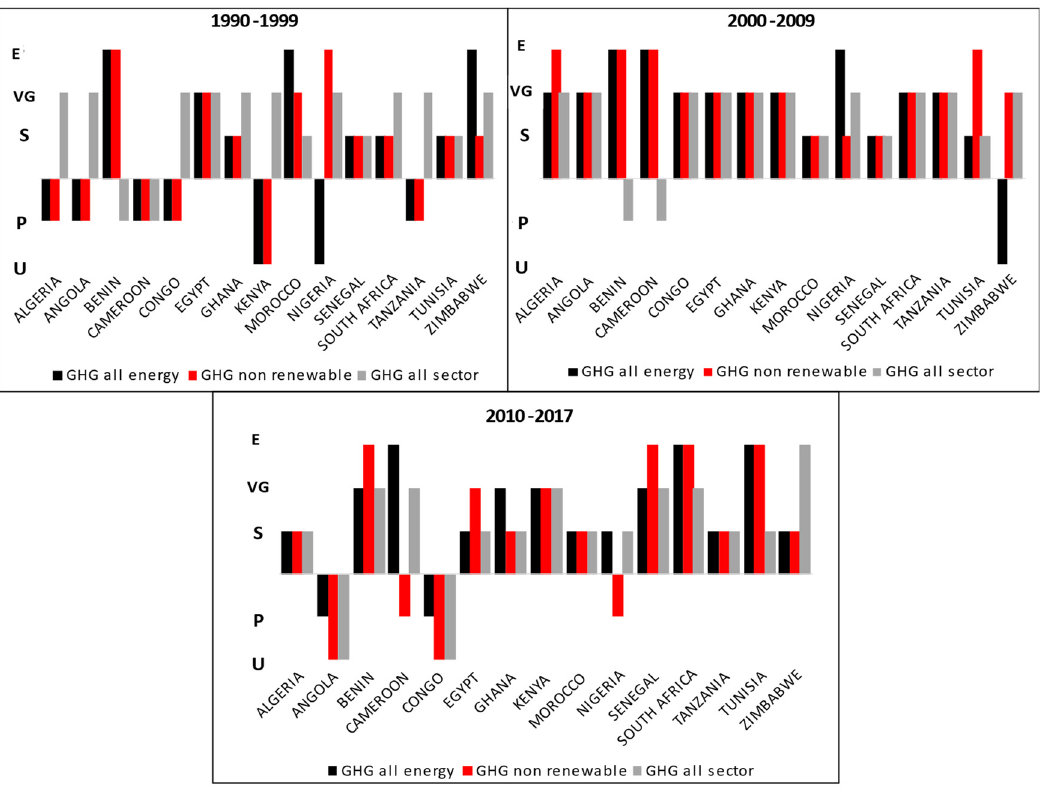
Figure 4. EWF’s GHG footprint-Water’s GHG footprint.